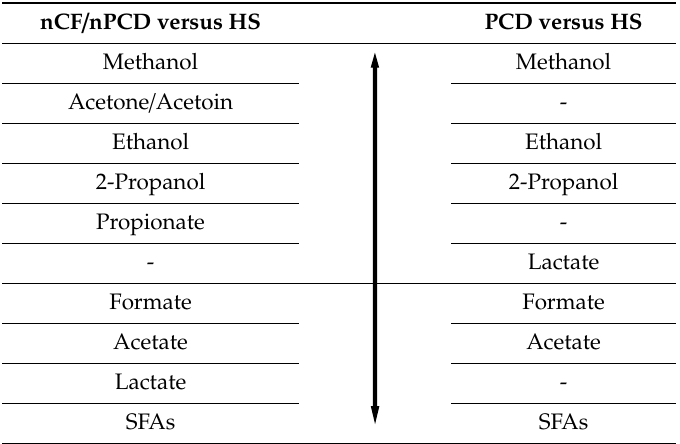
a nCF, non-cystic fibrosis; nPCD, non-primary ciliary dyskinesia; HS, healthy subjects; SFAs, saturated fatty